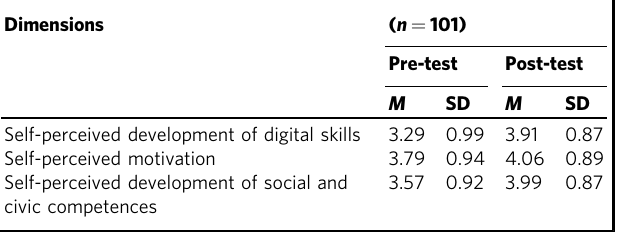
Table 3 Descriptive statistics of participants ’ self-perceived level of digital competence when blogging.